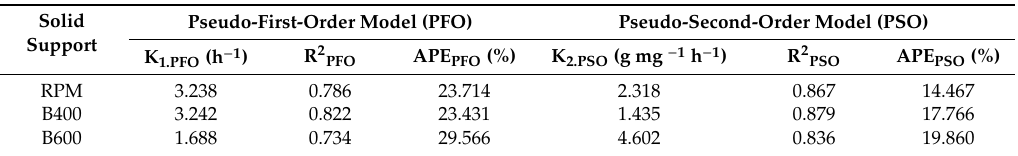
Table 2. Kinetic parameters of phosphorus release by RPM and its two derived biochars at 400 and 600 ◦ C.